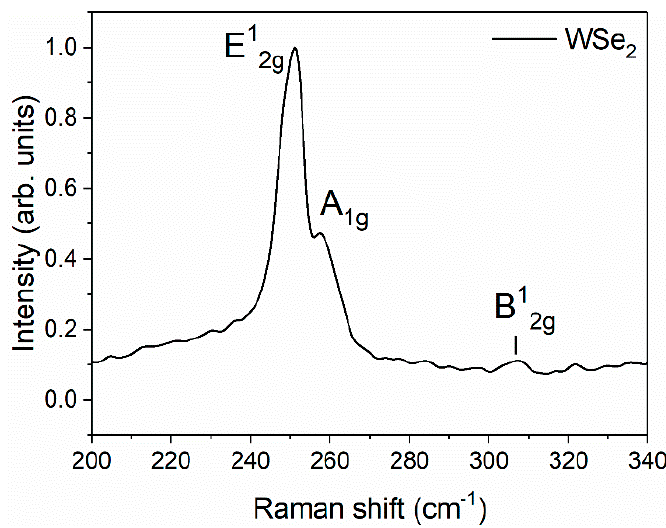
Figure 4. Raman spectrum of WSe 2 .